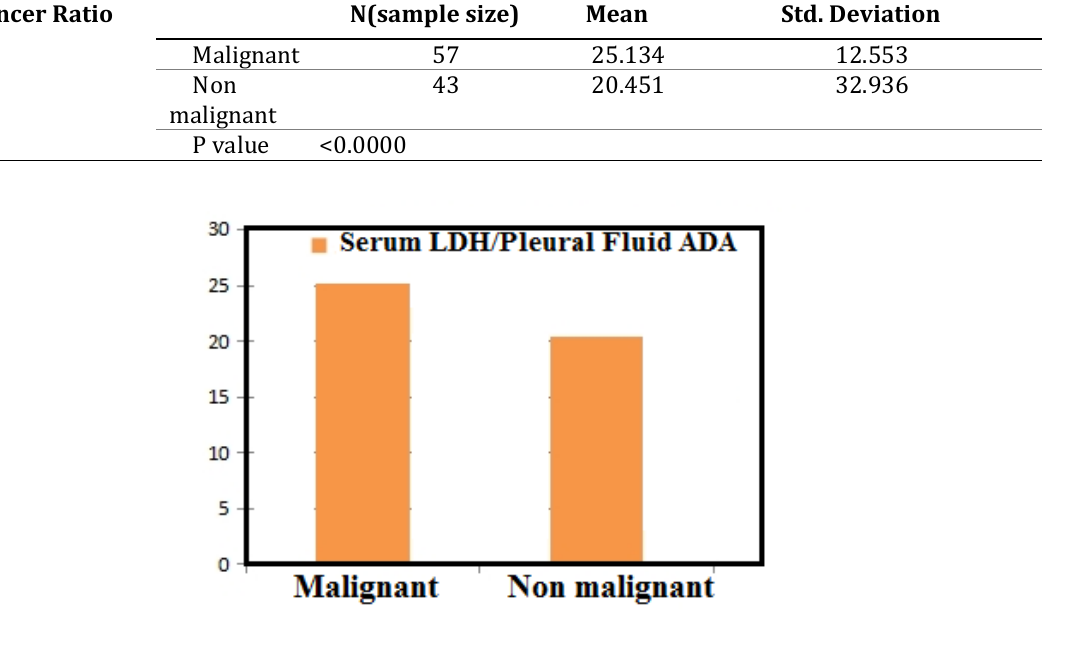
Figure 1: Ratio of Serum LDH/Pleural fluid ADA in malignant and non-malignant pleural